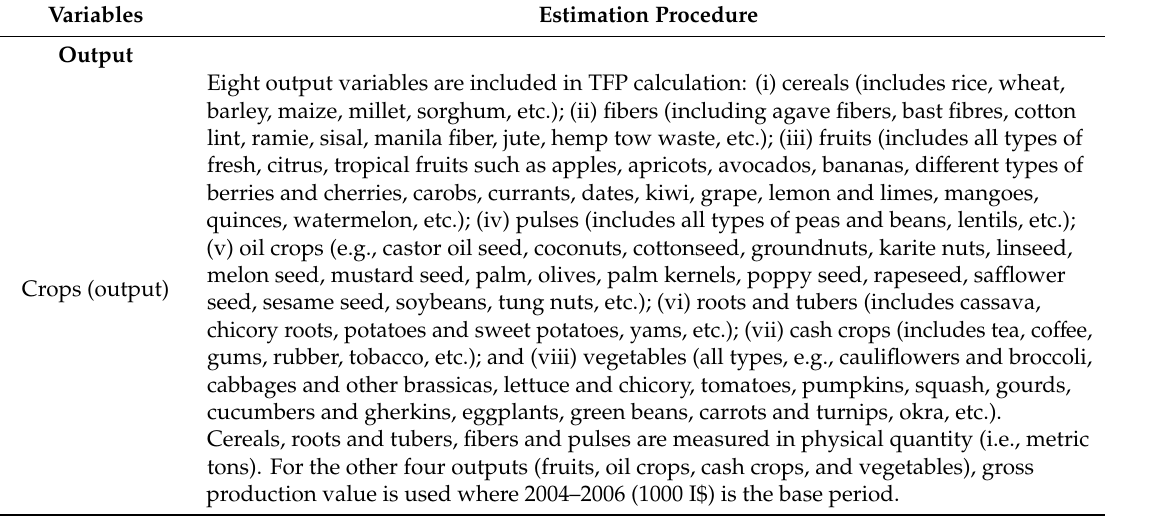
Table 1. Output-input variables and their estimation